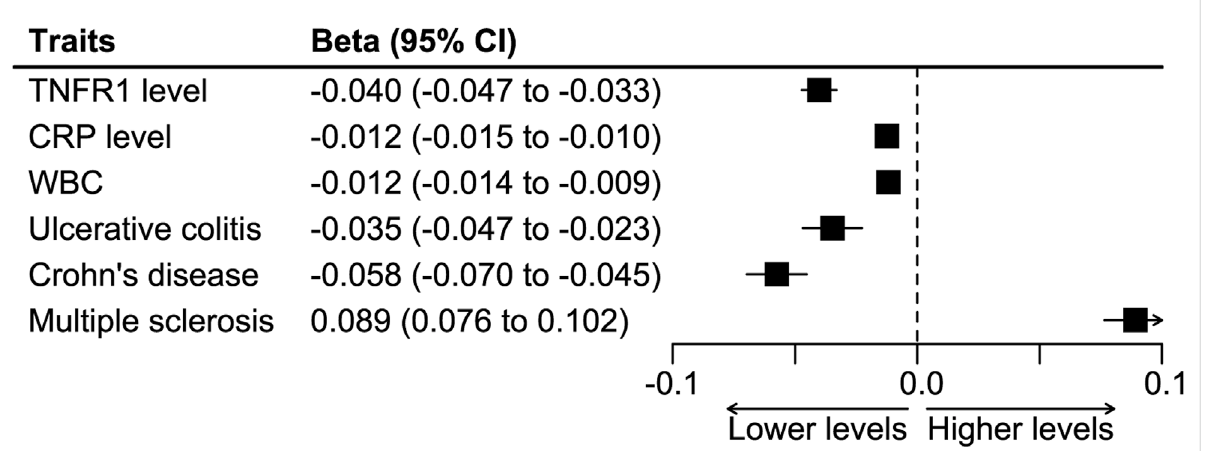
FIGURE 3 Synthesized effect of the SNPs on in fl ammatory biomarkers and clinical traits. Abbreviations: CRP, C-reactive protein. TNFR1, tumor necrosis factor receptor 1. WBC, white blood count.